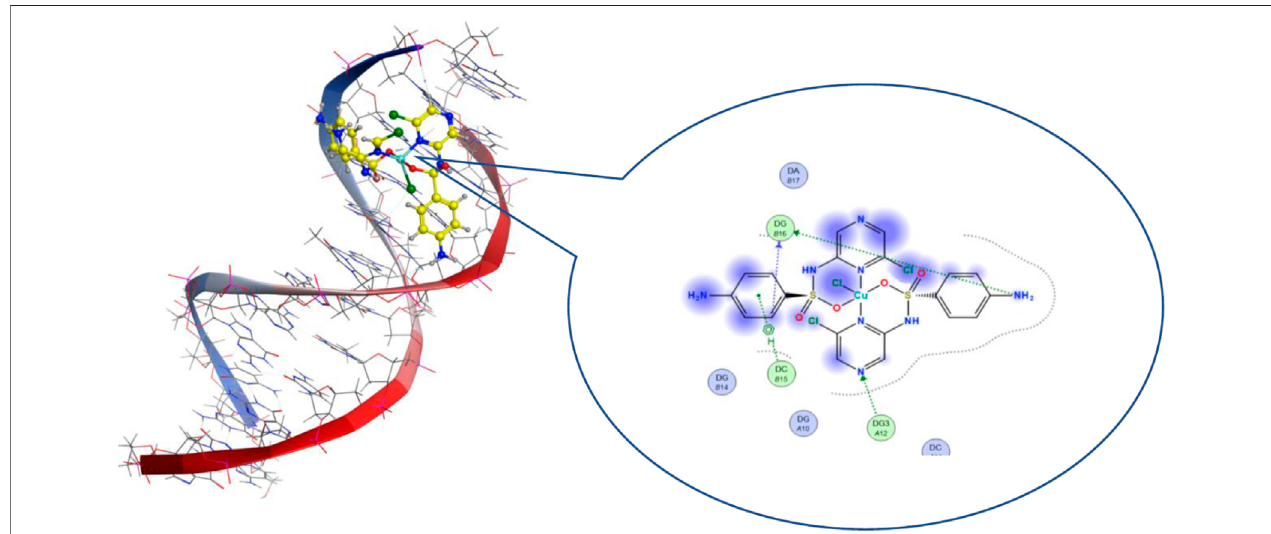
FIGURE 8 | 3D and 2D views of interactions of 8 with B-DNA.